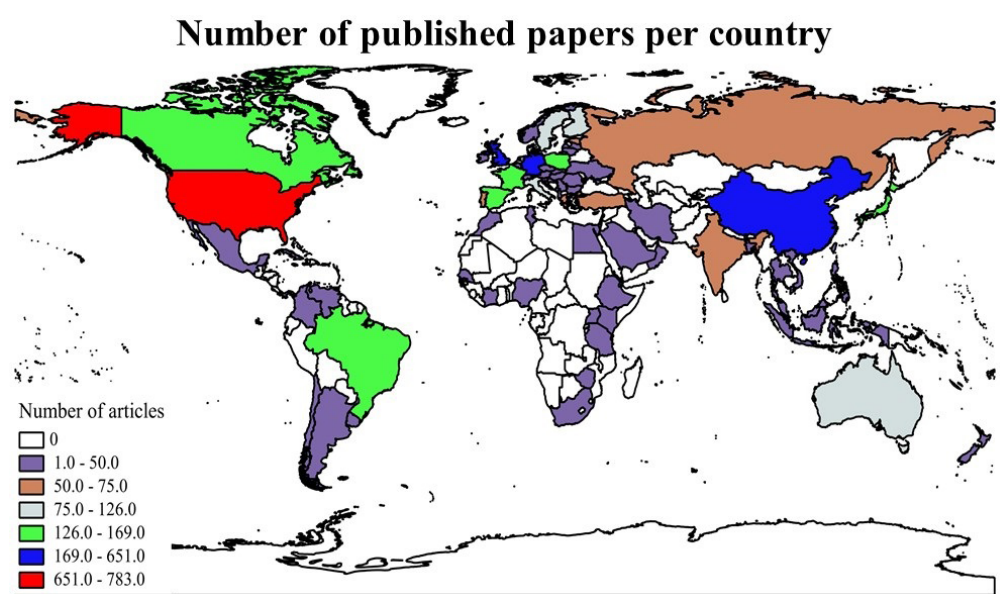
Figure 3. The most common institution of the correspondence author of the papers analyzed during